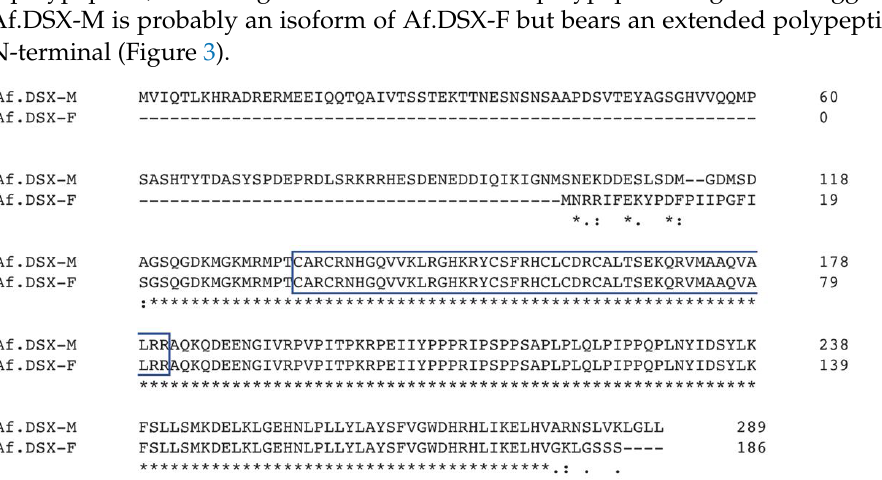
Figure 3. The alignment of primary polypeptide A. franciscana Af.DSX-F and Af.DSX-M. The box indicates the DM domain sequence; the asterisks indicate the conserved amino acids.